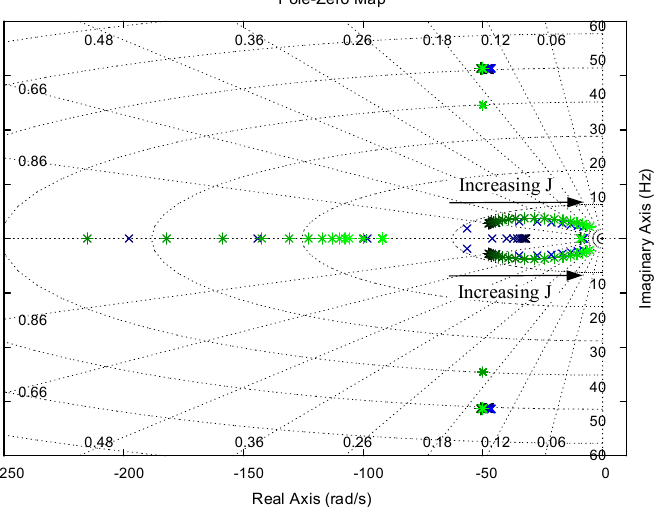
Figure 3. The impact of J (increased from 0.06 to 6) and the introduced current lowpass filters on the poles distribution of synchronverter system. Cross: poles without current lowpass filters. Asterisk: poles with current lowpass filters.